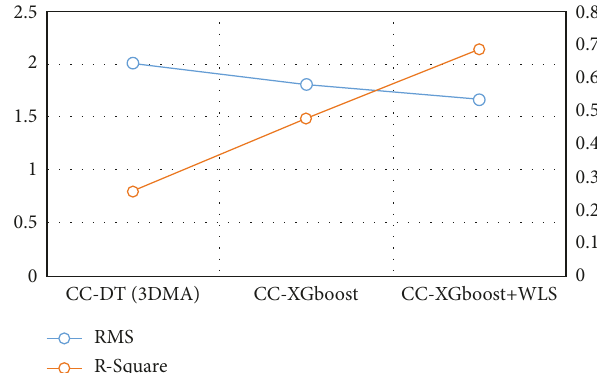
Figure 11: The trends in evaluation indicators under different methods.